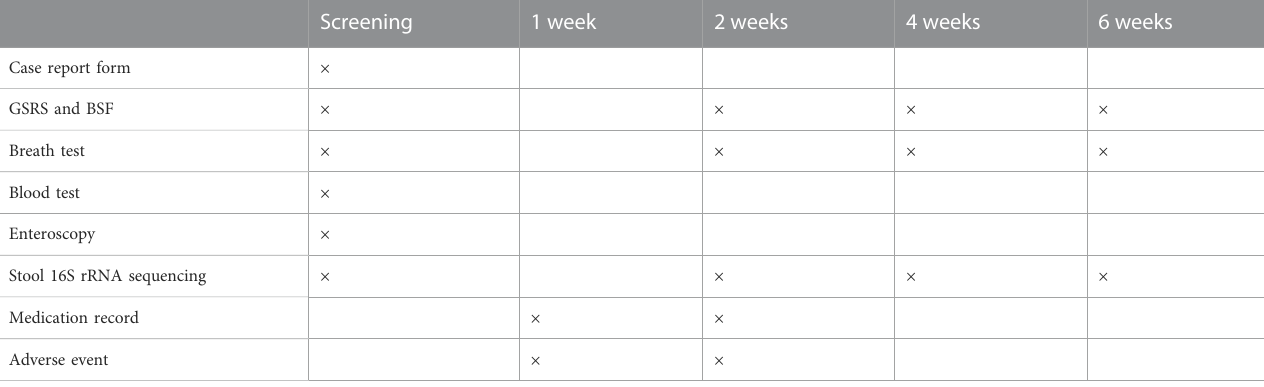
TABLE 1 Standard protocol items: Adapted recommendations for interventional trials (SPIRIT) schedule: Enrollment, interventions, and follow-up.